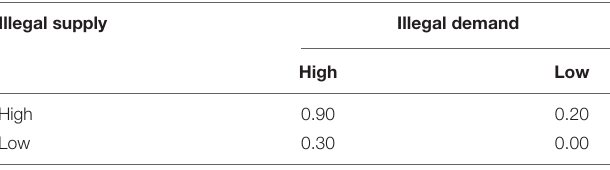
values—known as states . A node might have only two